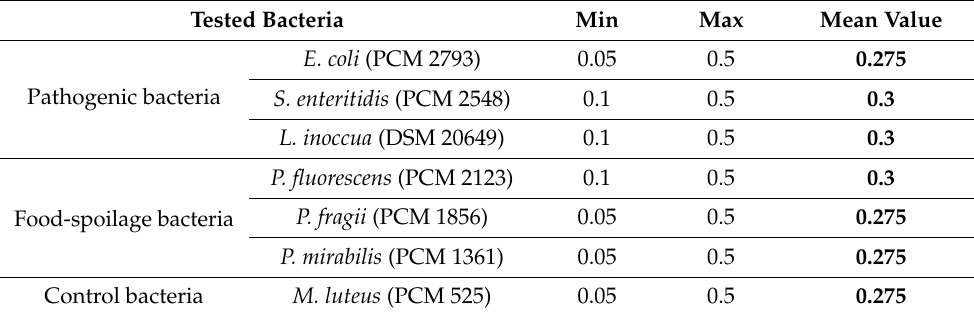
Table 5. The minimum inhibitory concentrations (MIC) [%] of the elderberry extracts. Tested